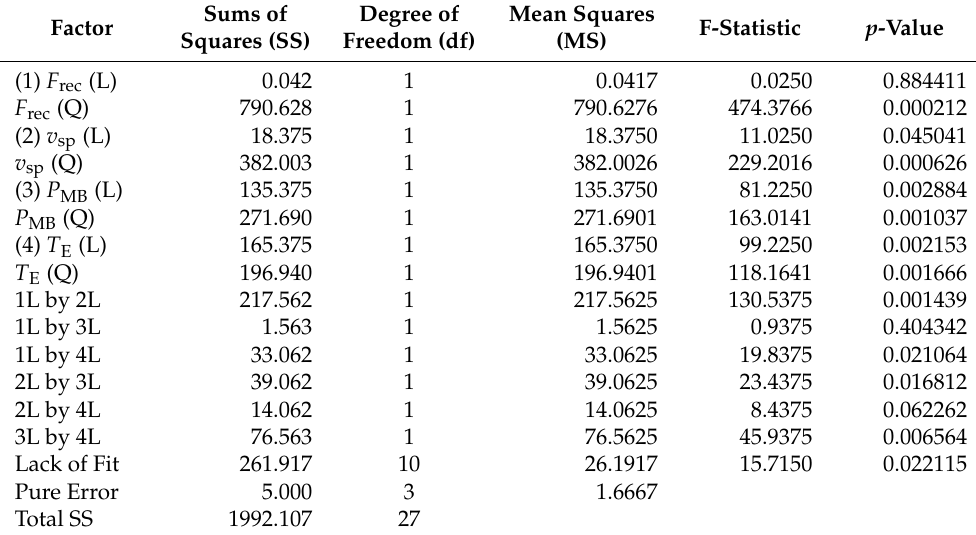
Table 5. Results of the analysis of variance (ANOVA) applied to data of percentage efficiency of oil and grease removal collected in tests carried out with the semi-industrial IPST according to the CCRD. Sums of Degree of Mean Squares F-Statistic p -Value Factor Squares (SS) Freedom (df) (MS)